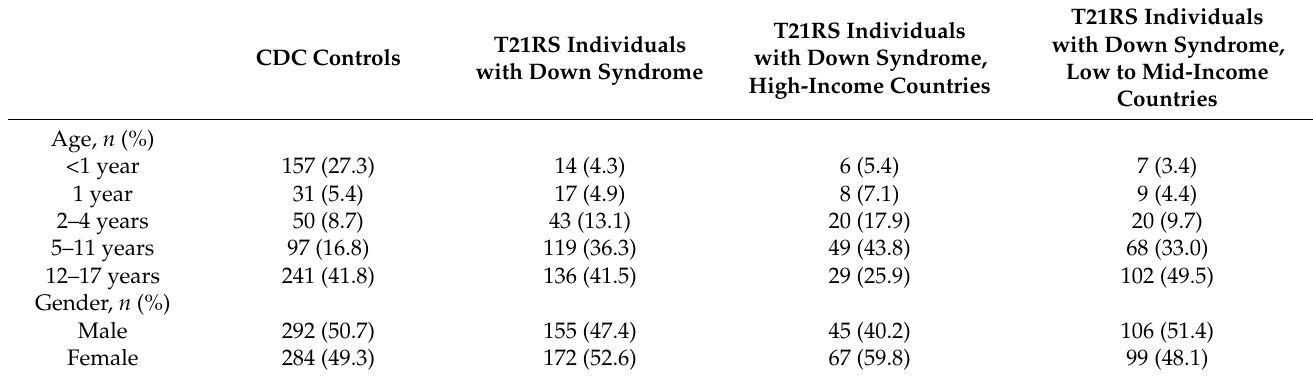
Table A3. Study characteristics of T21RS individuals with Down Syndrome (stratified by high-income and low to middle- income countries) and CDC controls without Down Syndrome.